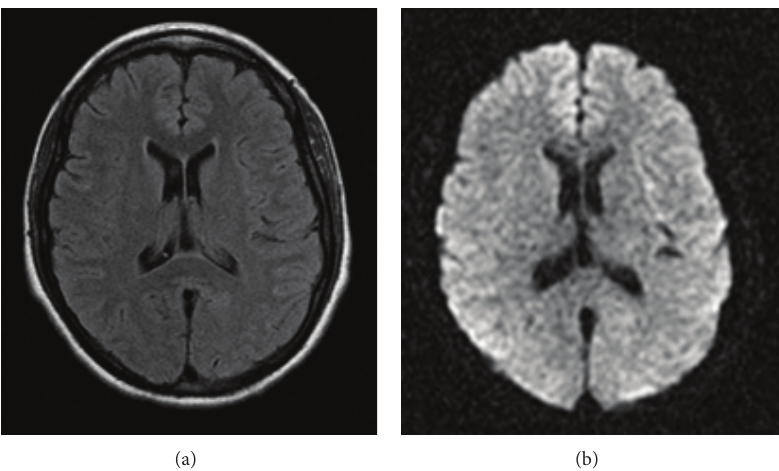
Figure 2: (a) MRI on FLAIR sequence showing mild diffuse subcortical edema. (b) MRI in diffusion sequence, without signal